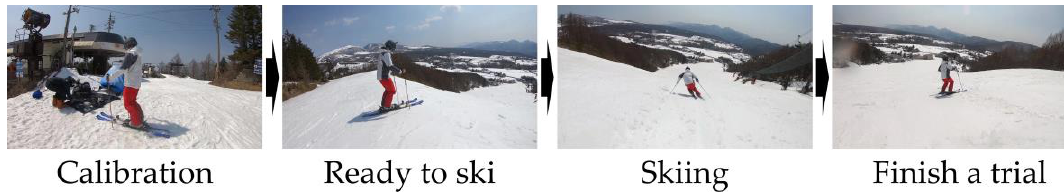
Figure 4. Experimental procedure in each run. Before skiing, the participant stood still for five seconds to calibrate the sensors. Then the participant moved to the top of the slope and started